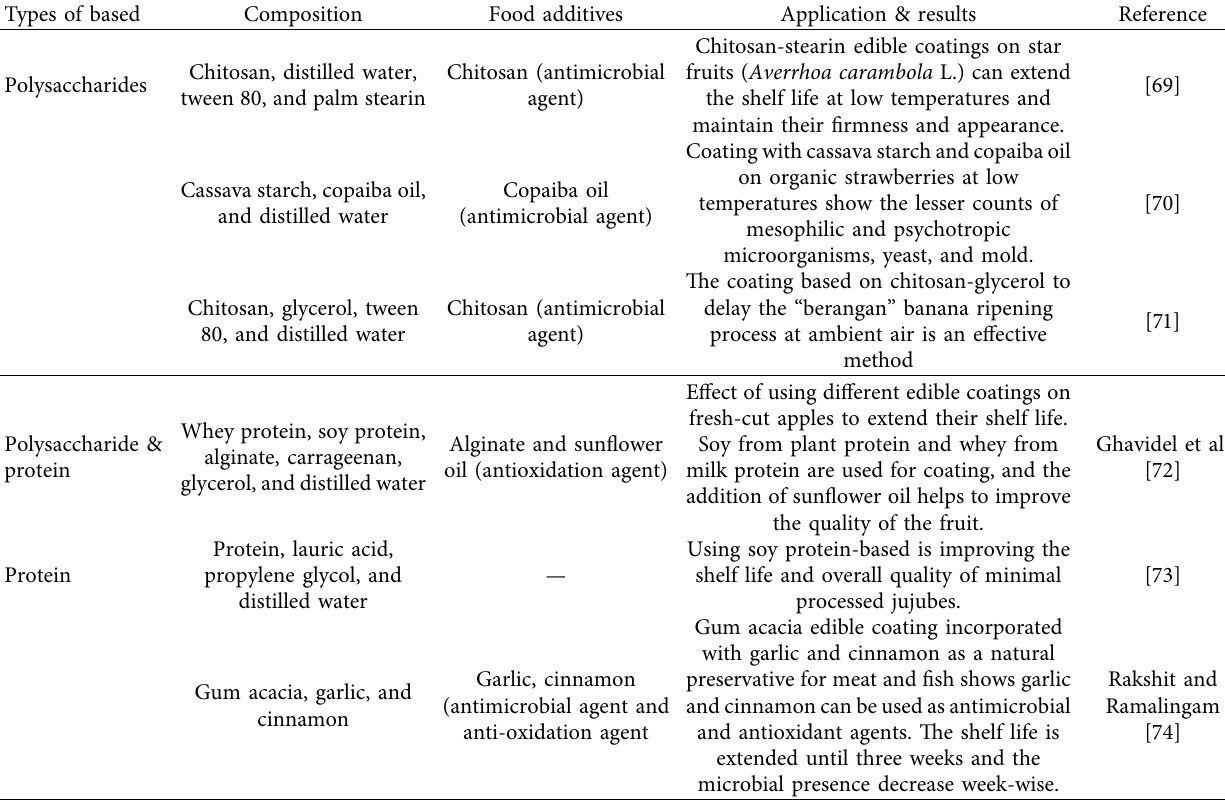
Table 4: Application of edible coating to extend the shelf life of